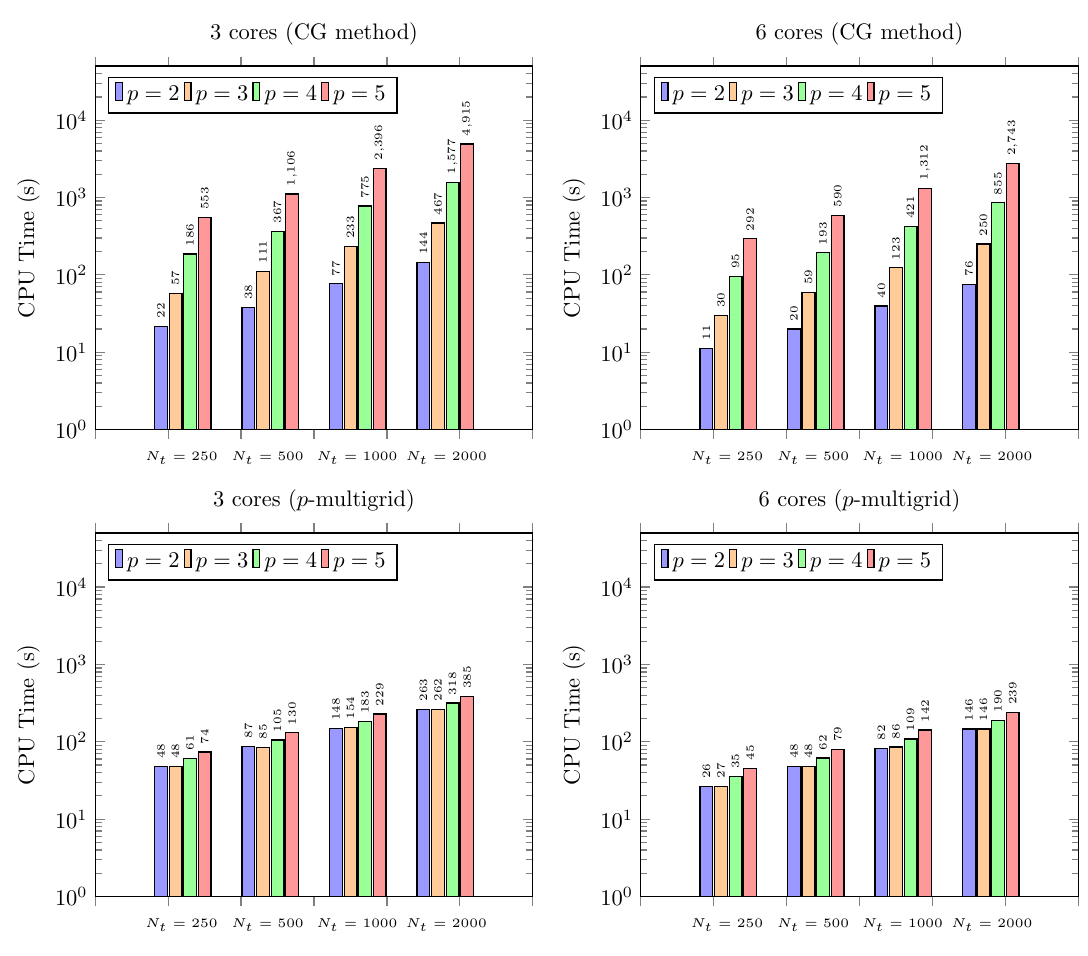
(top) and a p -multigrid method (bottom) are used for all spatial solves within MGRIT